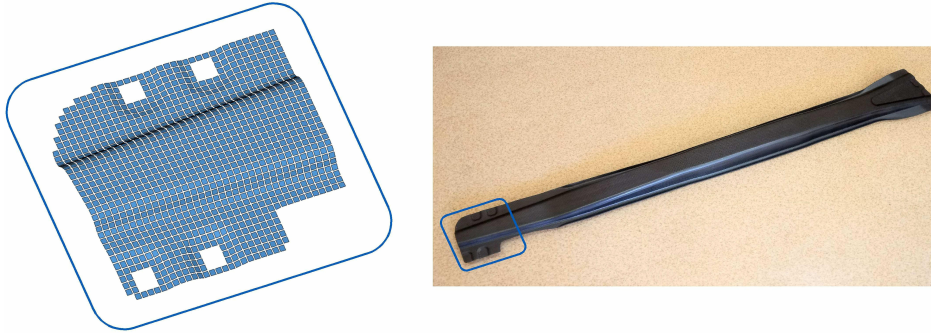
Figure 7: Door beam and a fragment of its surface model with visible four-node finite elements.